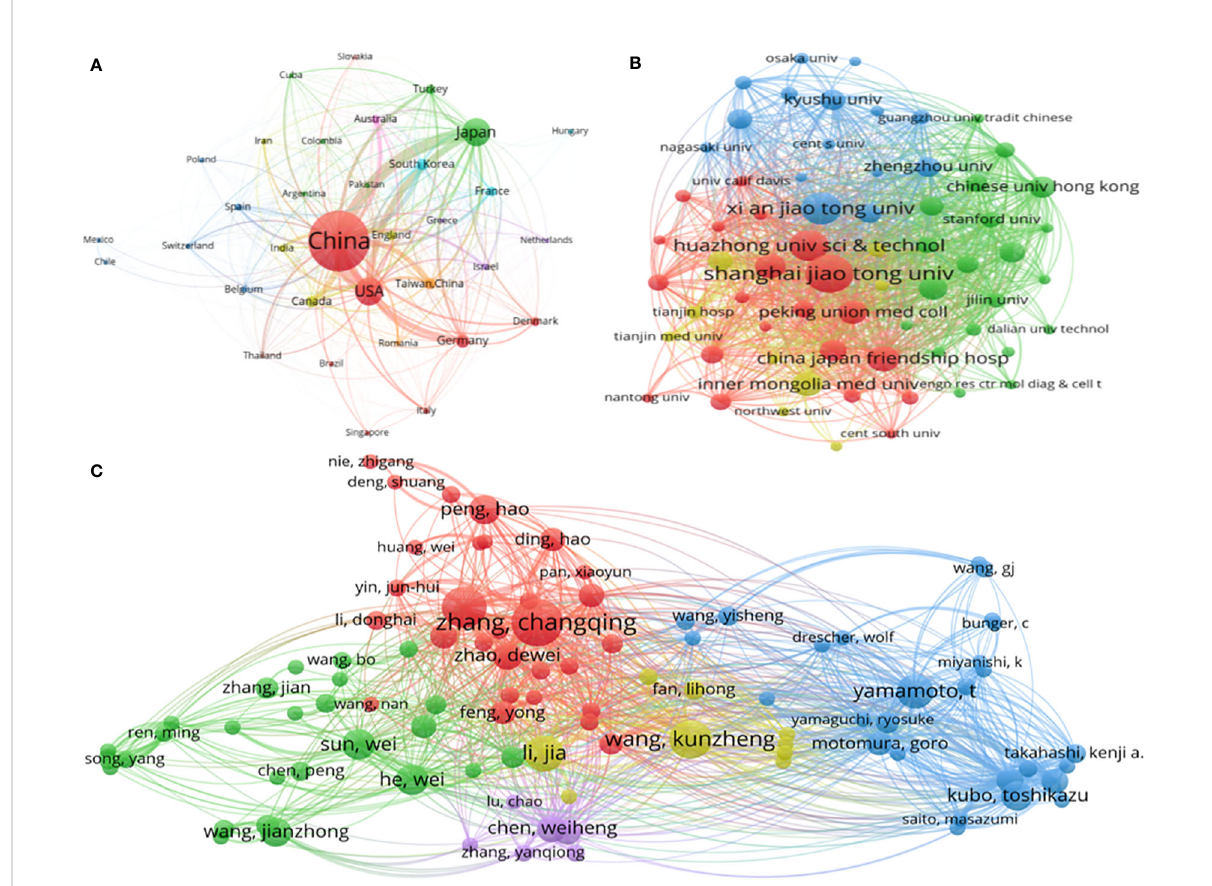
FIGURE 5 Bibliographic coupling analyses of global publications in SONFH in the last 30 years. (A) Network visualization of the 35 identi fi ed countries/ regions in SONFH. (B) Network visualization of the 65 identi fi ed institutions in SONFH. (C) Network visualization of the 102 identi fi ed authors in SONFH. Each circle represents an item; the size of the circle represented the number of publications of the item. The distance between two circles represents the correlation of the items, a closer distance with a stronger association. The color of an item is determined by the cluster to which it